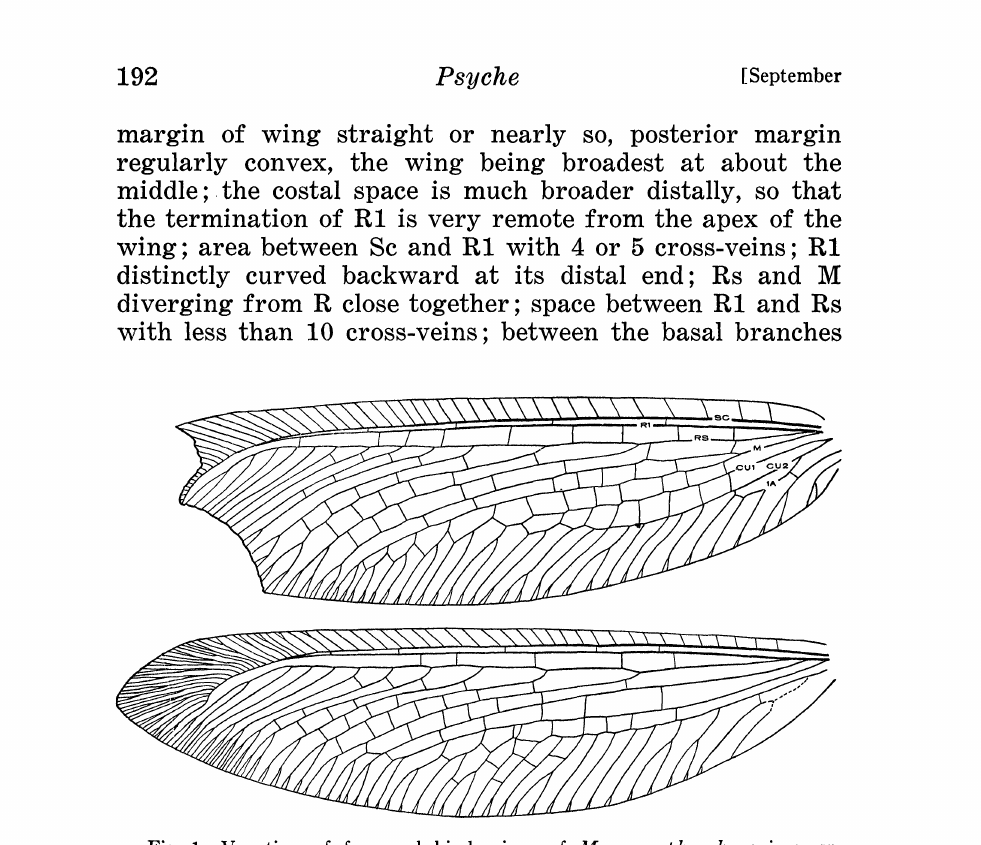
Fig. Venation of fore end hind wings of Mesonymphes hageni, n. sp. Sc, subcosta; R1, radius proper; Rs, radial sector; M, media; Cul and Cu2, branches of cubitus; 1A, first